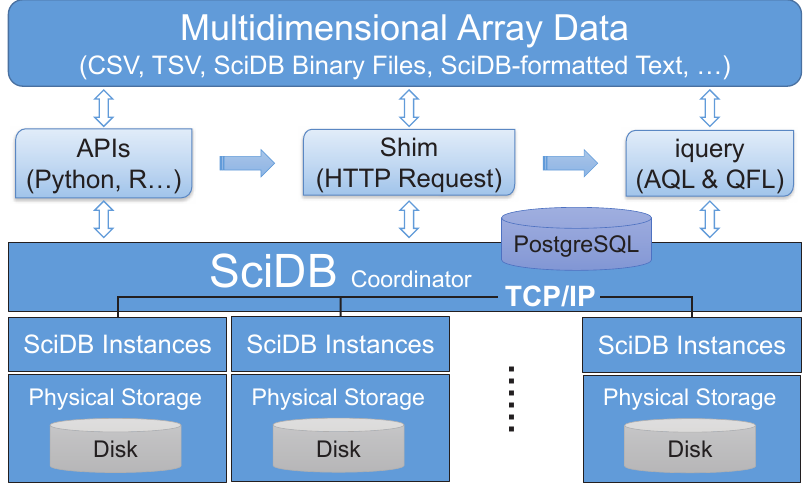
Figure 1. System architecture of